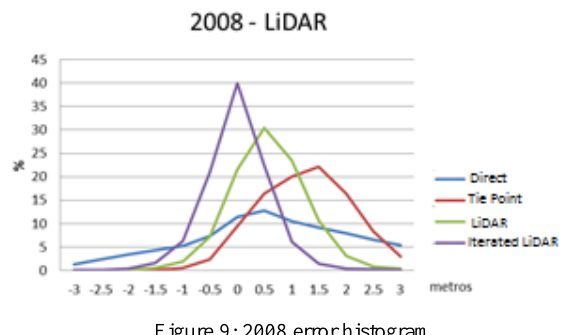
Figure 9: 2008 error histogram